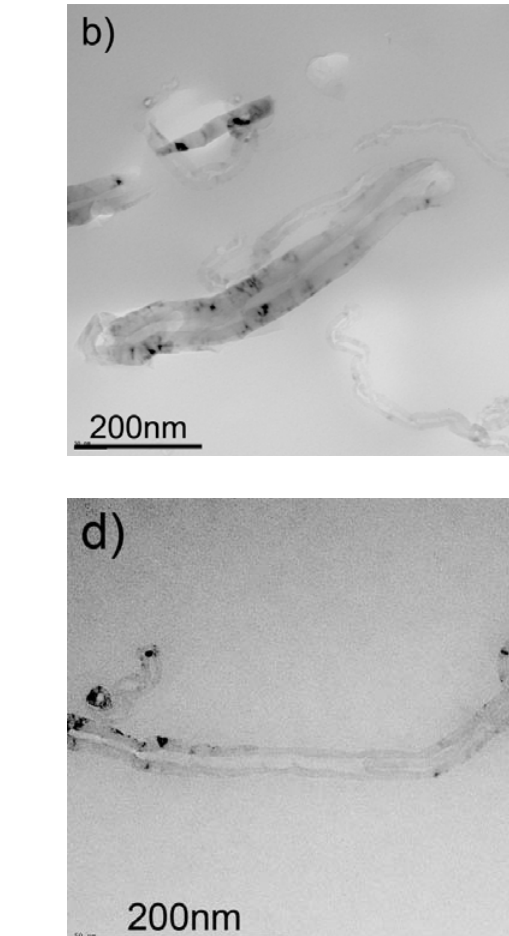
Figure 8. TEM images of microtomed epoxy composite reinforced by ( a , b ) untreated 60–100 nm diameter MWCNTs, and ( c , d ) plasma nanocoated 10–30 nm diameter MWCNTs at various